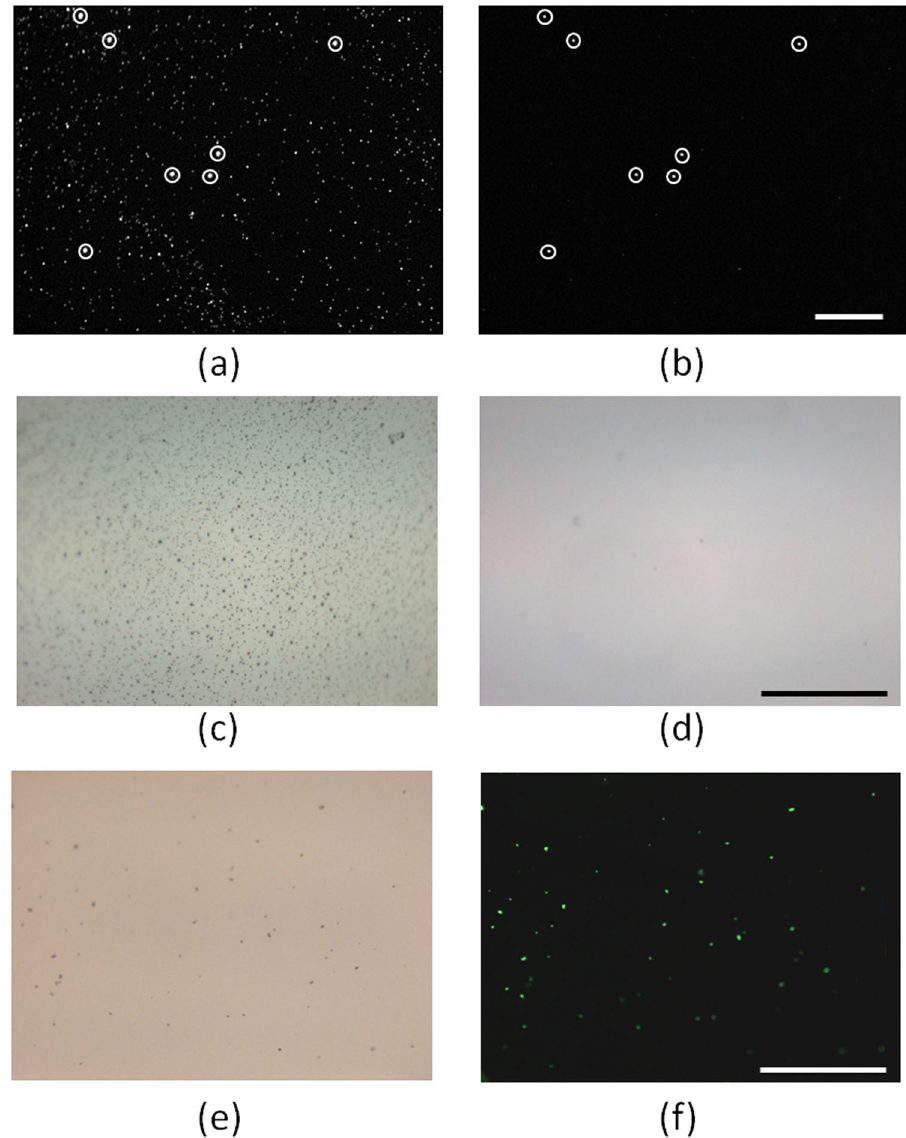
Figure 3. Fluorescence image of 0.25 µ m and 1 µ m polystyrene beads under ( a ) blue excitation and green emission (green channel), and ( b ) green excitation and red emission (red channel). ( c ) Brightfield image of the virus sample placed on a substrate without the PEG layer. We observe a significant level of non-specific binding. ( d ) Brightfield image of the virus sample without antibody tagging on a substrate with the PEG coating. ( e ) Brightfield image of the virus sample conjugated with biotin tagged antibody and FITC tagged antibody, placed on a substrate with PEG coating. ( f ) The corresponding fluorescence image of the same virus sample (an overlapped RGB image). Scale bar: 100 µ